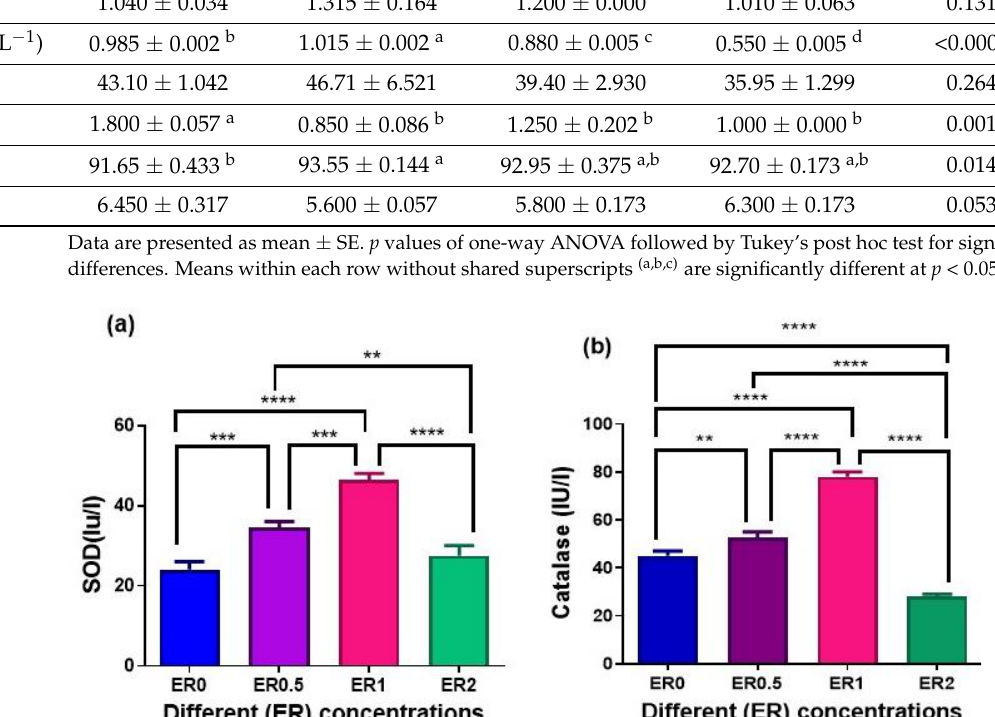
Table 7. The immune response of Red tilapia fed different dietary levels of ER. ER Dietary Level (%) p -Value ER0 ER0.5 ER1 ER2 Data are presented as mean ± SE. p values of one-way ANOVA followed by Tukey’s post hoc test for significant differences. Means within each row without shared superscripts (a,b,c) are significantly different at p < 0.05.